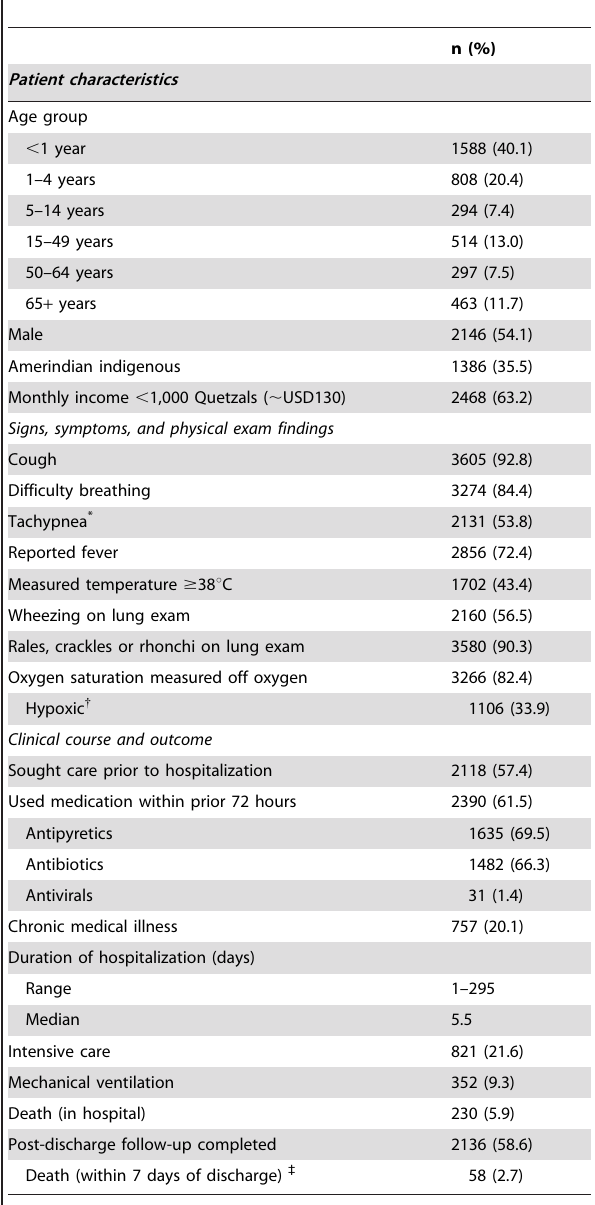
Table 2. Characteristics of patients hospitalized with acute respiratory infection,